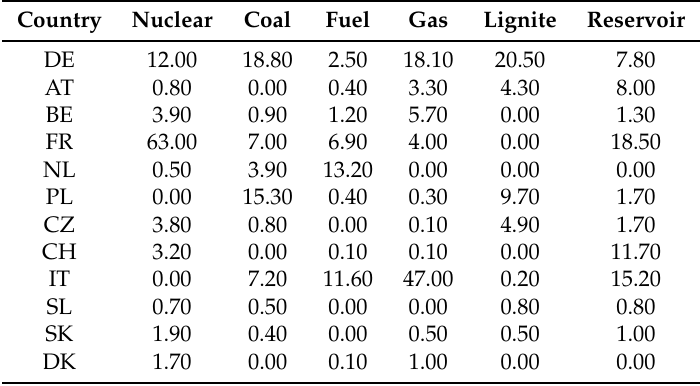
Table 5. Capacity of dispatchable generation in GW